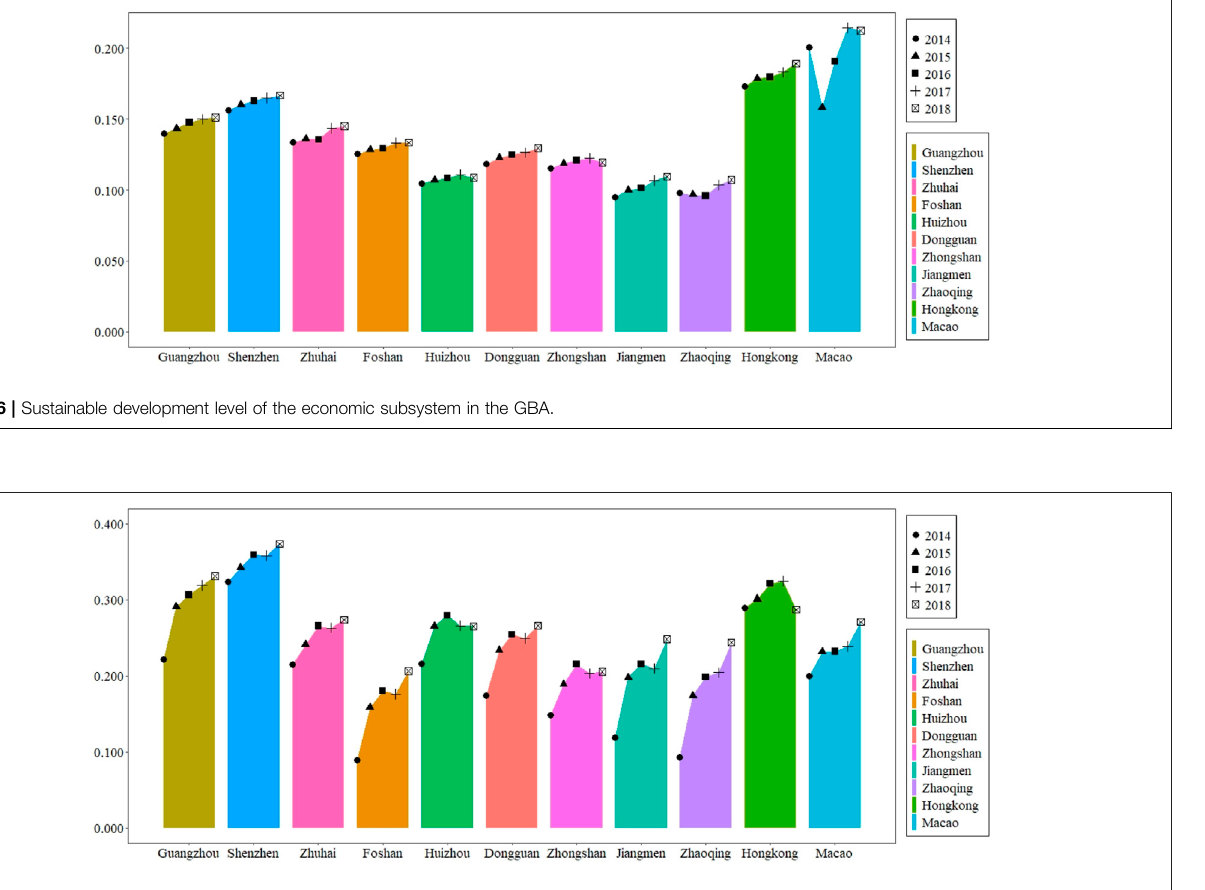
FIGURE 7 | Sustainable development level of the natural subsystem in the